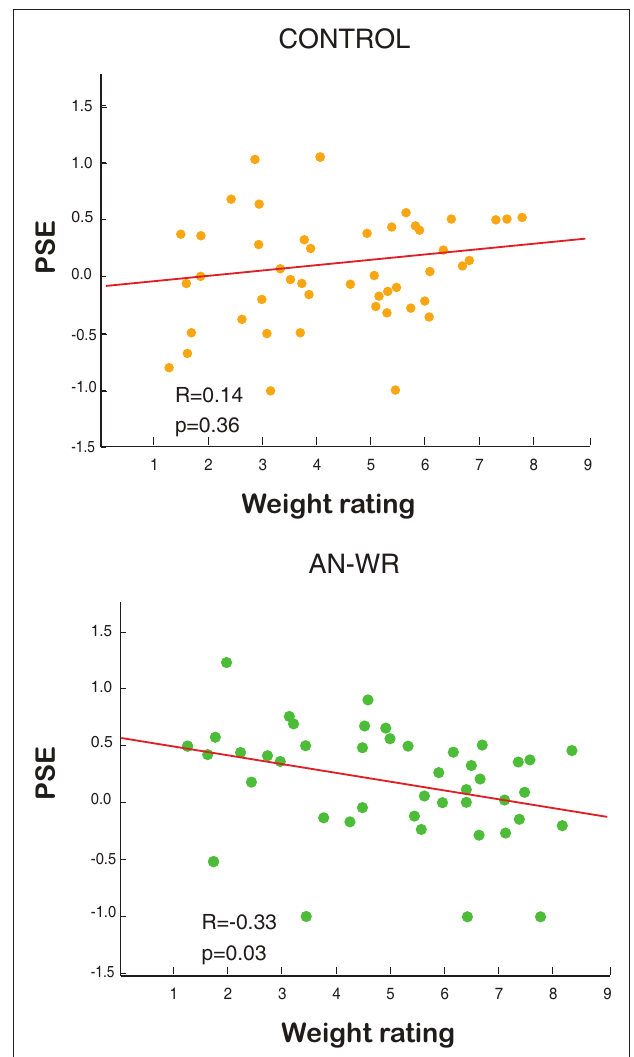
Figure S2 | Whereas there is no significant correlation between the body weight of the depicted image and the amount CON subjects will pay to see that image (left), the amount AN-Wr subjects will pay in order to see a body image is inversely related to the weight of the depicted image (right). Each data point in the plots above corresponds to a single image weight category for a single subject; hence, there are four data points per subject. Weight rating indicates the mean weight rating assigned to images in that image category as reported by the subject. PSE (point of subjective equality) is the payout subjects will relinquish at a point of equal choice frequency between the image and non-image options (see Methods for details). Units are in US